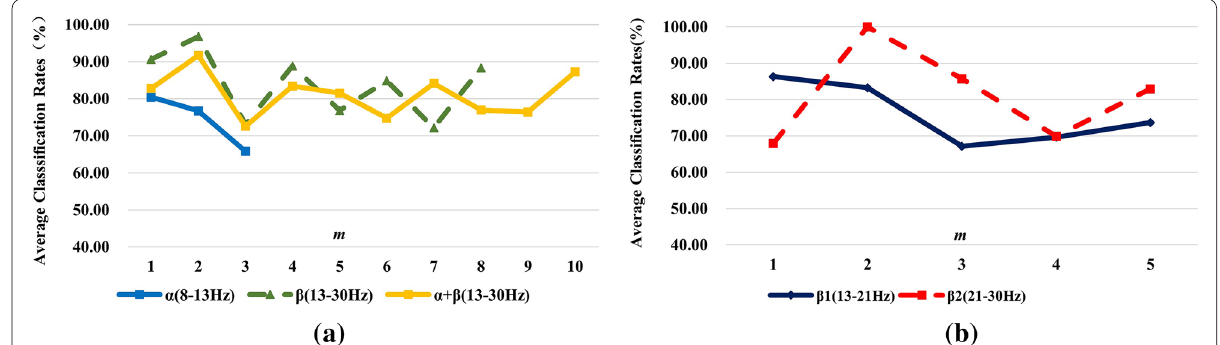
Fig. 5 Effects of different frequency bands and m values on the classification results for subject ‘k3b’ a α , β and α